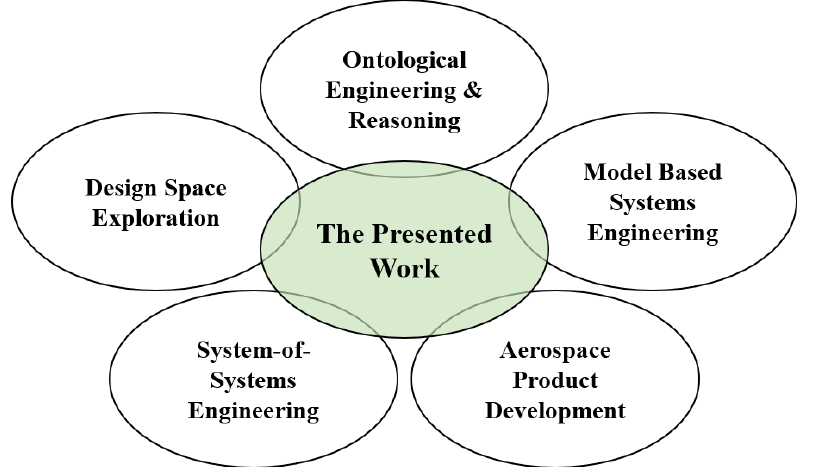
Figure 3. The presented work positioned relative to related areas and